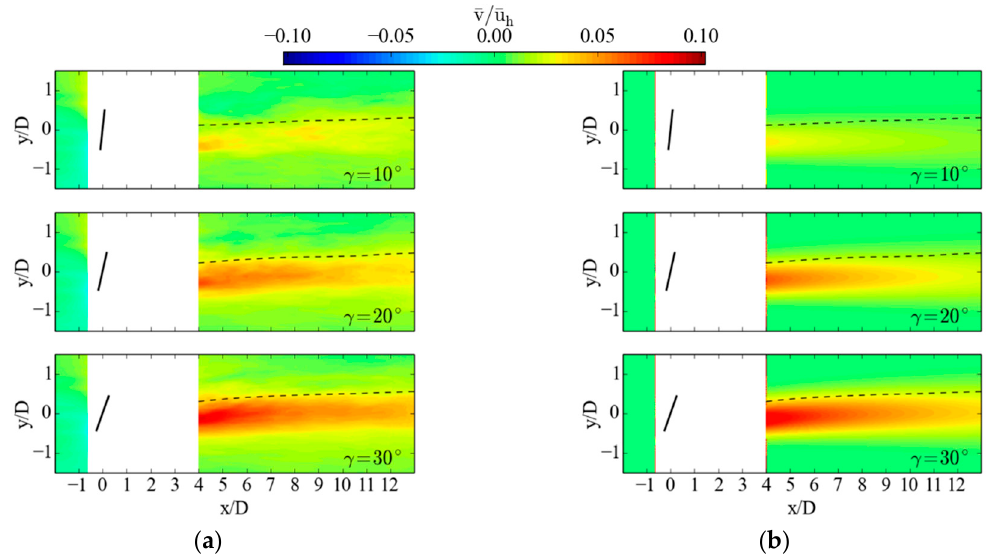
Figure 13. Contour plots of normalized transverse velocity in the horizontal plane at hub height for different yaw angles: ( a ) LES results; ( b ) predictions from the proposed model. The black solid lines denote the wind turbine rotors. The black dashed lines represent the wake center trajectories.